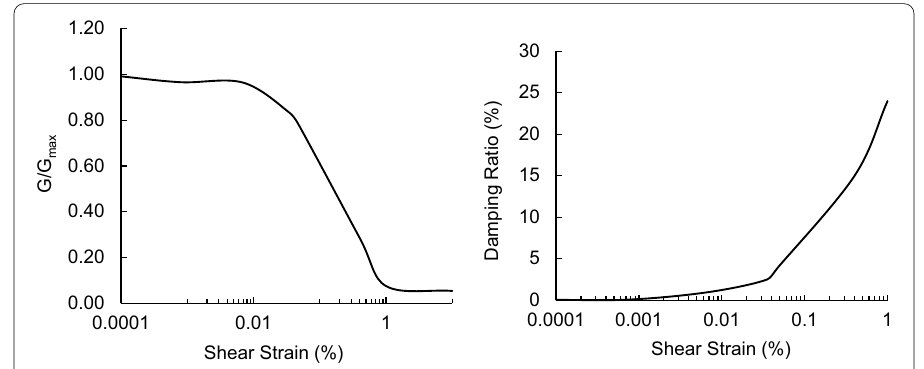
Fig. 7 Shear modulus reduction curves and damping ratio curves for Ottawa F65 sand as obtained from hypoplastic constitutive model parameters with intergranular